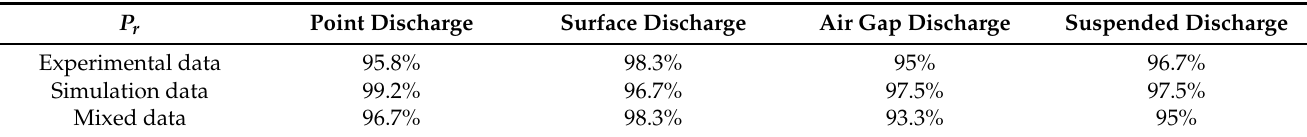
Table 3. PD recognition results for different data sets.